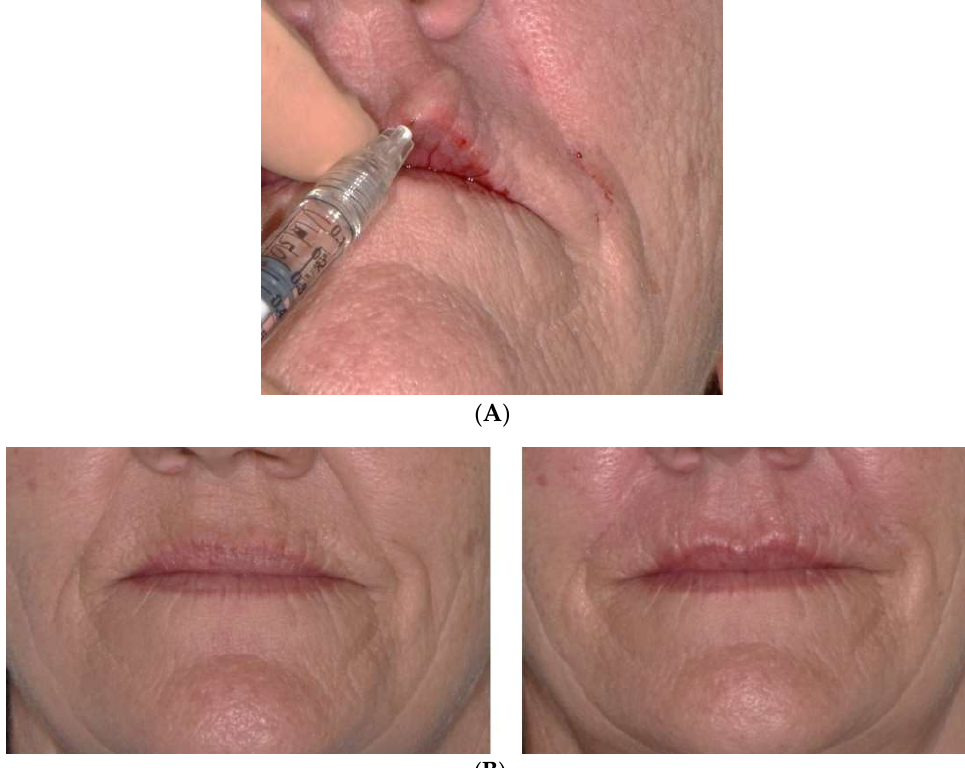
Figure 7. ( A ). Injection of hyaluronic acid in front of the upper lip. ( B ). Pre- and post-injection front view of a bimaxillary full denture patient seeking to reshape and redefine the lip contour.